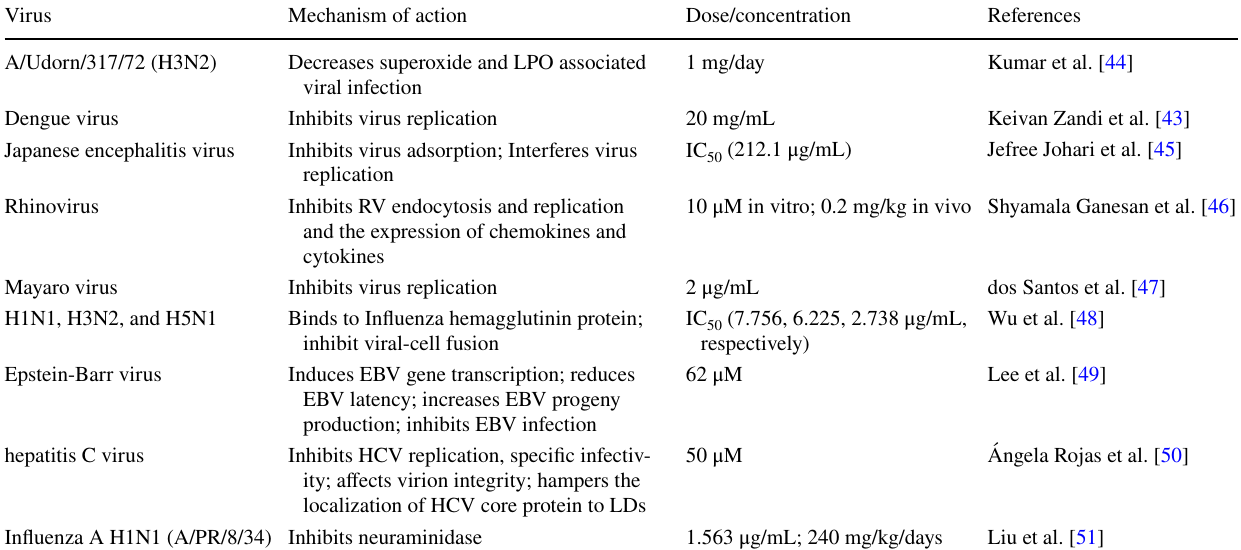
Table 2 Anti-virus activities of quercetin/IQ Virus